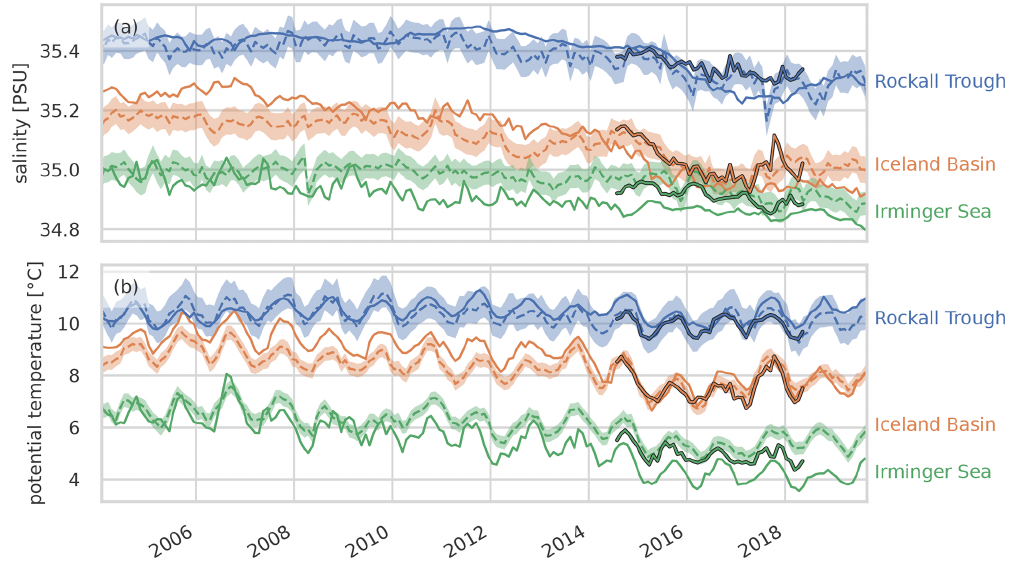
Figure 2. Model (plain solid lines) and observational (EN4, dashed lines; OSNAP, bold lines from 2014) time series of (a) salinity and (b) temperature in three zones – in the Irminger Sea, Iceland Basin, and Rockall Trough – along the eastern section of the OSNAP (Overturning in the Subpolar North Atlantic Programme) line, OSNAP E (see Fig. 1 for the positions of the zones). All time series are monthly means and are averaged over the upper